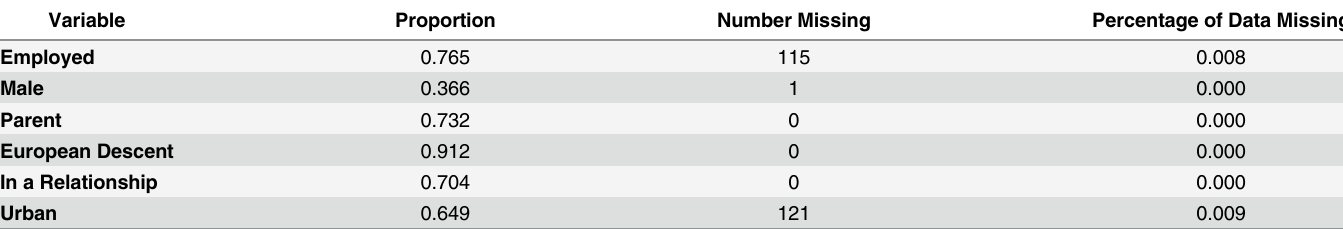
Table 2. Dichotomous Variables Used in